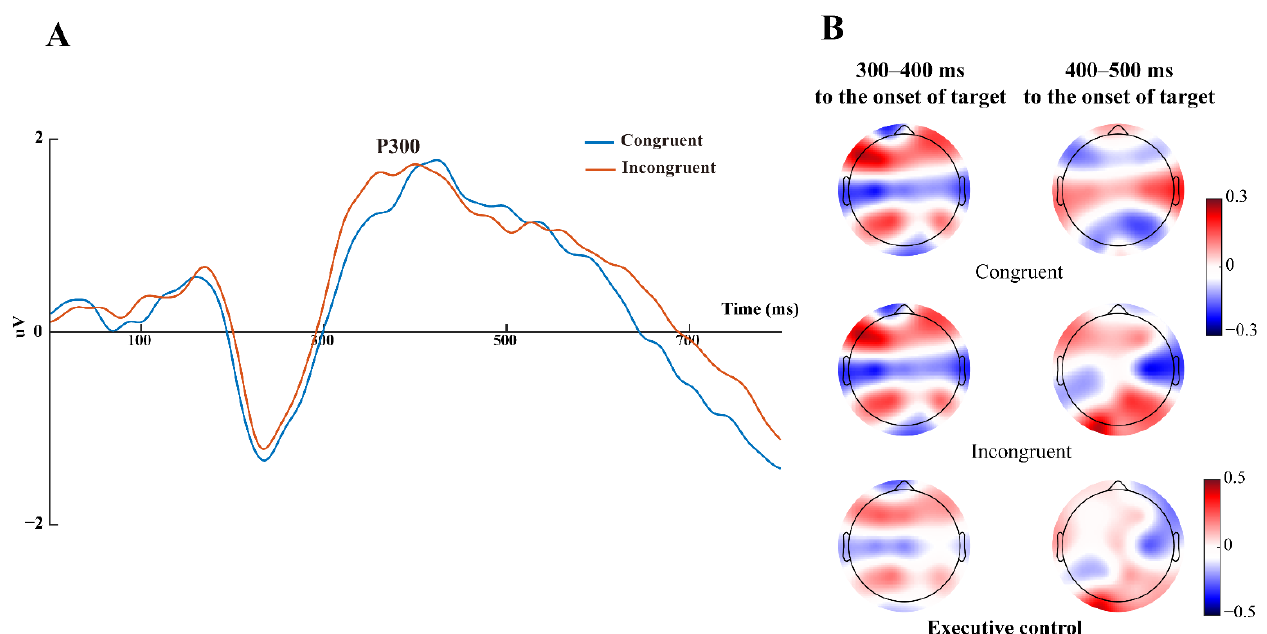
Figure 6. ERP waveforms and CSD topographical maps of 2 target conditions and executive control effect: ( A ) grand average ERP waveforms stratified by target conditions on electrodes Cz, C2, C4, CP2, CPz, CP4. Target stimulus onset is at 0 ms (solid line); ( B ) 2D top view of CSD maps of executive control effects within 300–500 ms after target onset (target-related P300). CSDs of executive control (bottom row) was obtained by subtracting averaged ERP of incongruent condition (middle row) from congruent condition (top row). Units are µ V/m 2